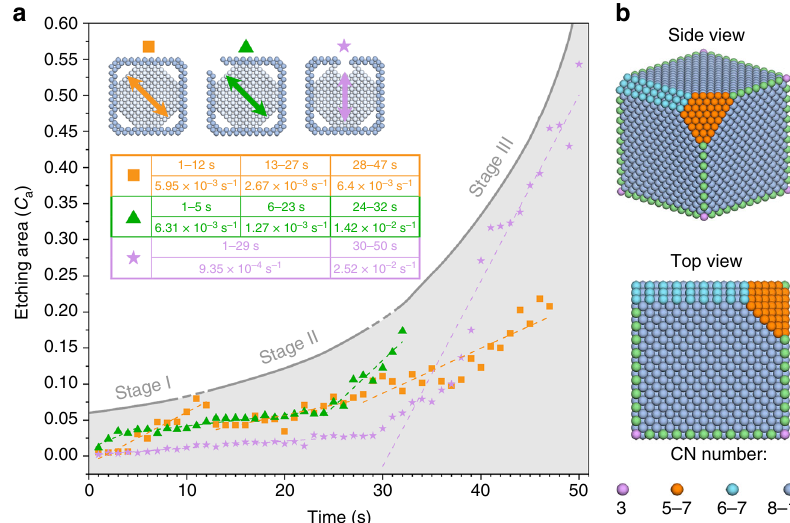
Fig. 4 Etching rate and coordination number of cubes. a Changes of the measured projected etching area along representative directions as a function of time in regular, corner and terrace defected cubes, respectively. Inset table shows the values of average etching rate in the corresponding periods of time. b Coordination number distribution of surface atoms of inside Pd